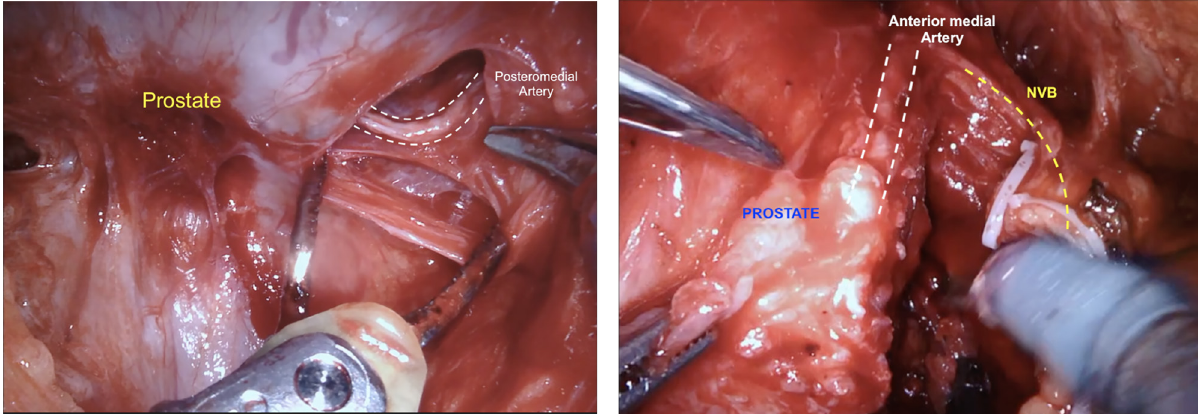
Figure 9 - Right side of the prostate describing the anterior medial artery attached to the prostate after a partial